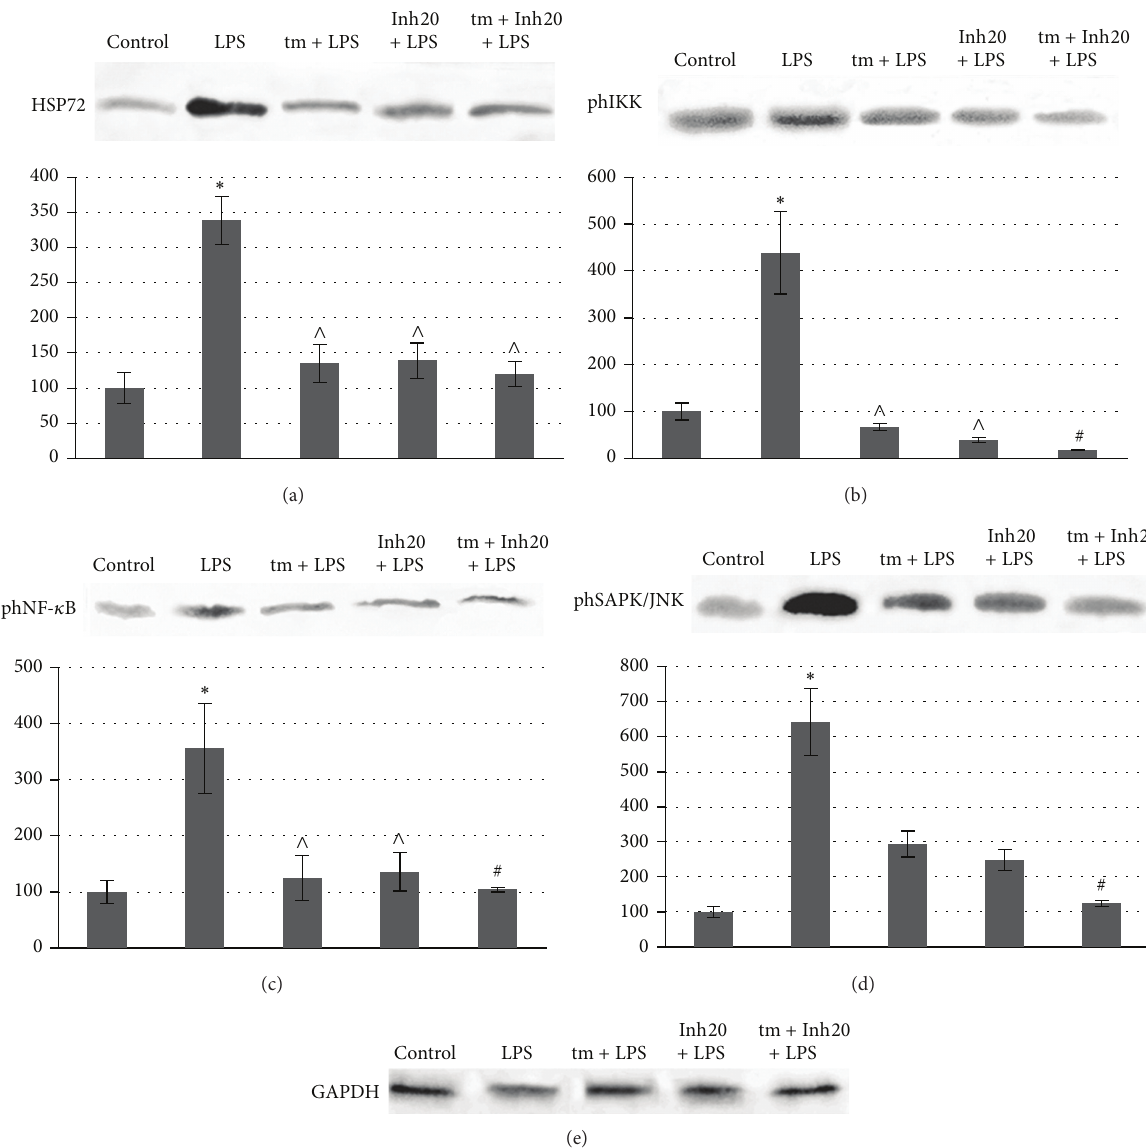
Figure 4: The effects of IKK Inhibitor XII and thymulin on phosphorylation of RelA, IKK, SAPK/JNK, and expression of Hsp72 in the splenocytes from inflammation-bearing mice. The animal’s groups that indicated in Figure 3 were used. Western blot analysis of extracts from isolated mice lymphocytes was provided using corresponding antibodies or anti-GAPDH antibody as loading control (bottom). Blot pictures show a single representative experiment for four independent experiments. Histograms below protein bands show protein levels calculated as mean relative units correspondingly to internal control and are the results of blots densitometry by program QAPA from four independent experiments. ∗ Significantly different from control, 𝑃 < 0.05 . ∧ Significantly different from LPS-group, 𝑃 < 0.05 . # Significantly different from (Inh+LPS)-group, 𝑃 < 0.05